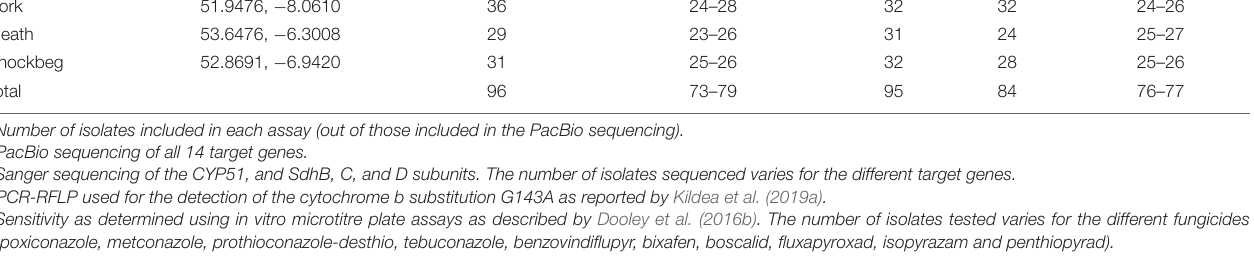
Frontiers in Microbiology |